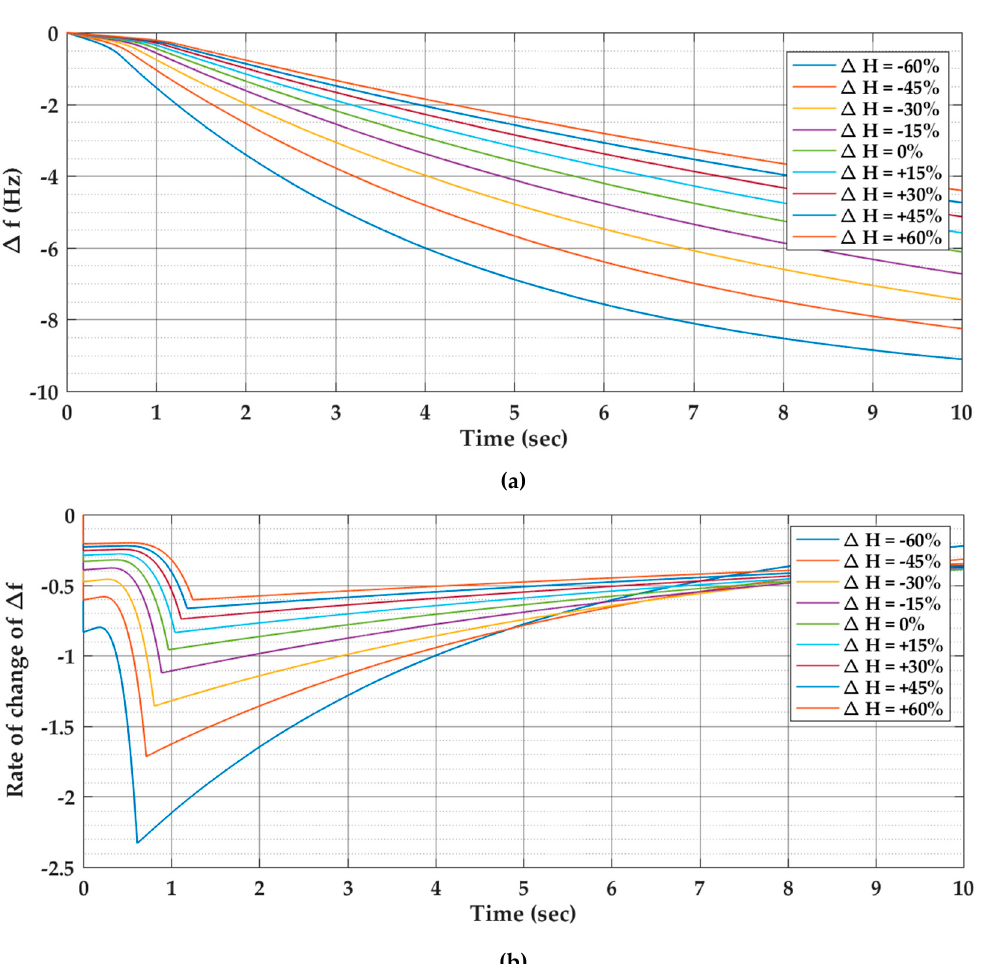
Figure 7. Effects of varying H on the PSFR for an unstable power system with primary and supplementary controls. ( a ) Frequency deviation due to step load disturbance. ( b ) Rate of change of the frequency deviation.